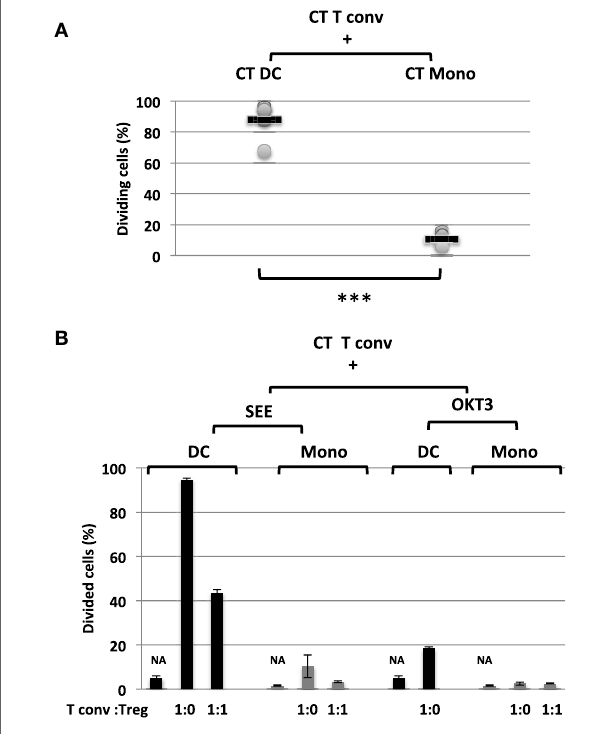
FigUre 4 | Proportion and function of CD11c + CD4 low subpopulations (a) shows the mean ± SD (range) proportion of proliferating naïve conventional effector T cell (Tconvs) from healthy controls (CTs) (CT Tconv), after carboxyfluorescein succinimidyl ester (CFSE) staining and incubation for 5 days with staphylococcal enterotoxin (SEE) and autologous control dendritic cells (DCs) (CT DC) [ n = 6; 88.1 ± 12% (67.3–94.7%)] or autologous control monocytes (CT Mono) [ n = 6; 10.6 ± 4% (6–16%)]. Statistical analyses were performed using a non-parametric T -test (*** p < 0.001). (b) shows the mean ± SD (range) proportion of proliferating naïve Tconvs from CTs (CT Tconv) after staining with CFSE and incubation for 5 days in the presence of SEE (0.2 ng/ml) or OKT3 (5 µg/ml) with either DC or monocytes. NA = non- activated cells. CT Tregs were added (or not) to give a Tconv:Treg ratio of 0 or 1. The error bars correspond to the mean ± SD for